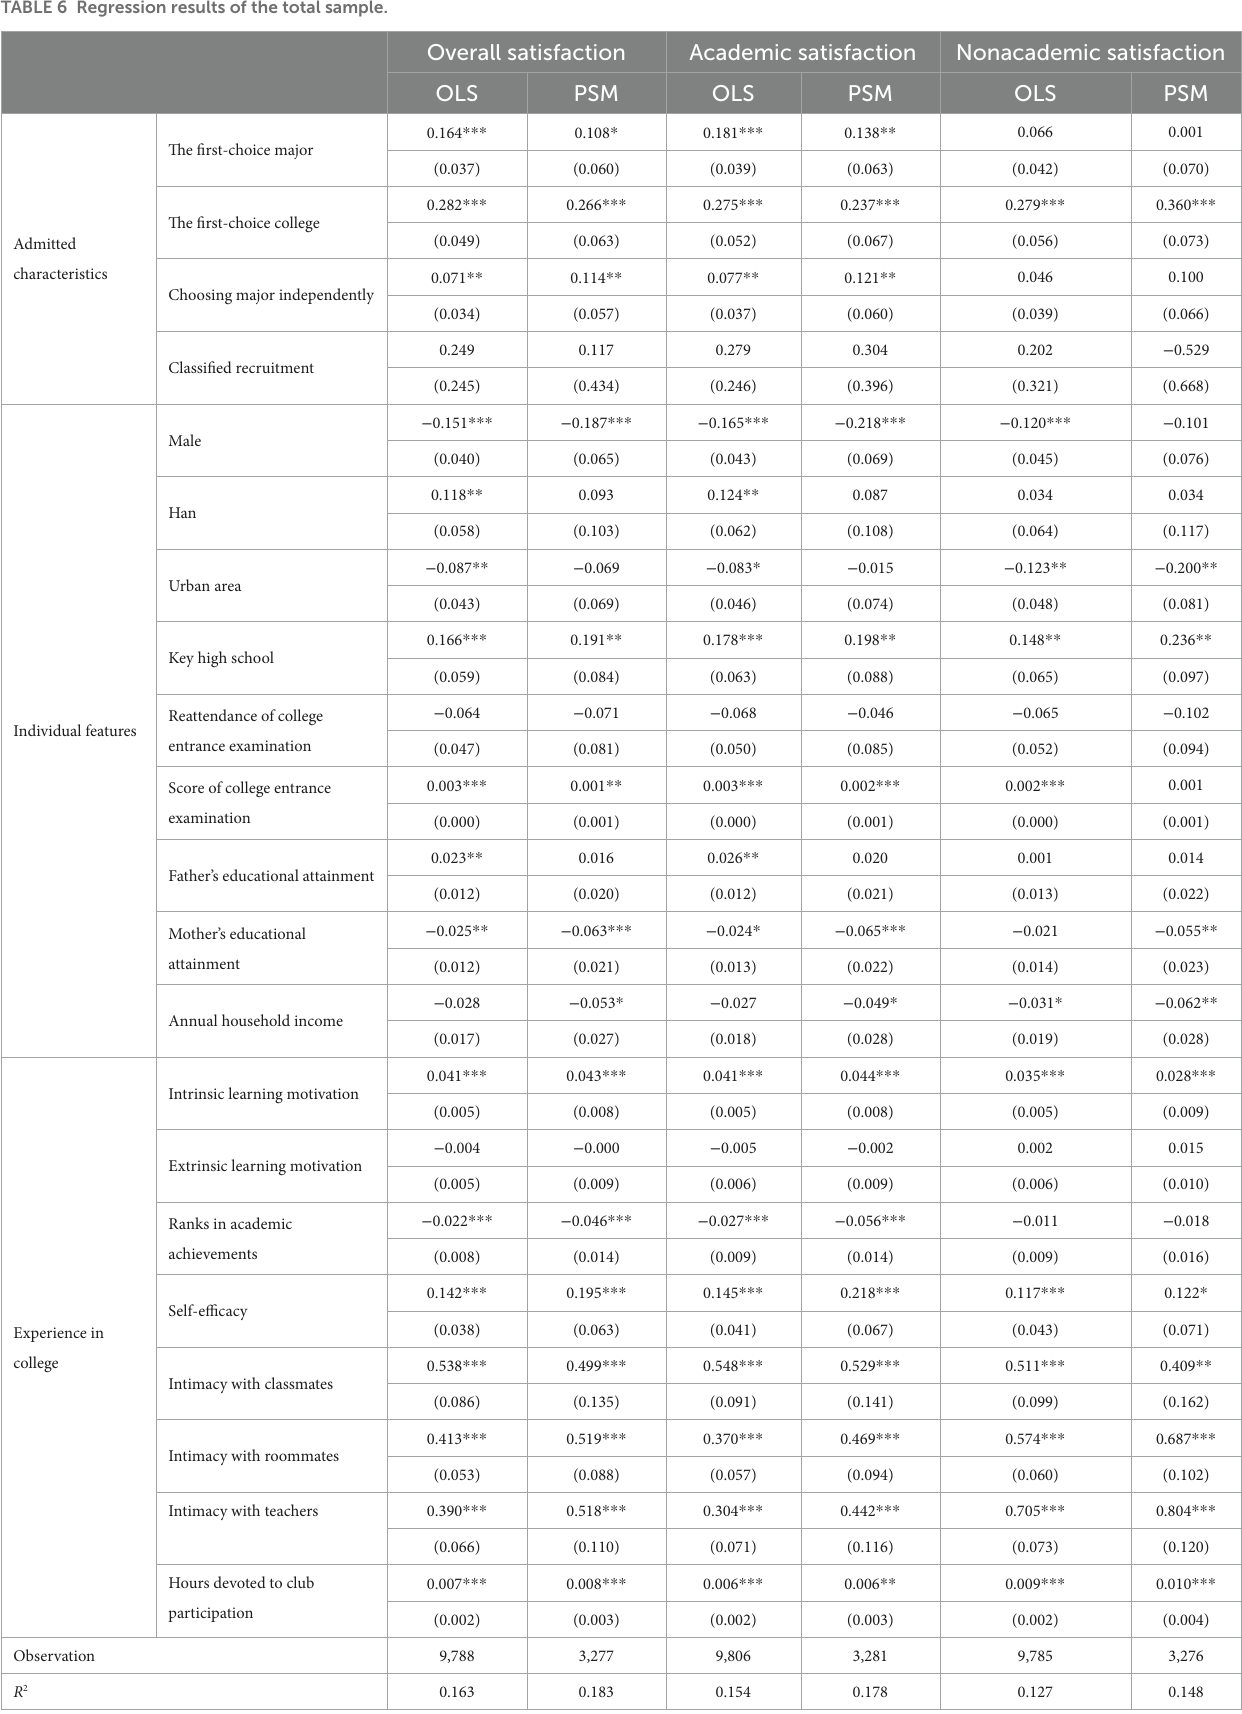
TABLE 6 Regression results of the total